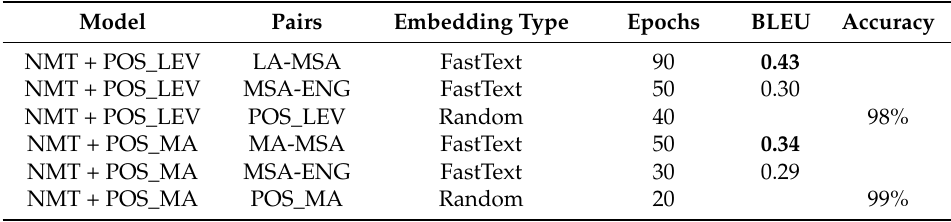
Table 2. Results of Multi-Task NMT with POS in terms of BLEU score.